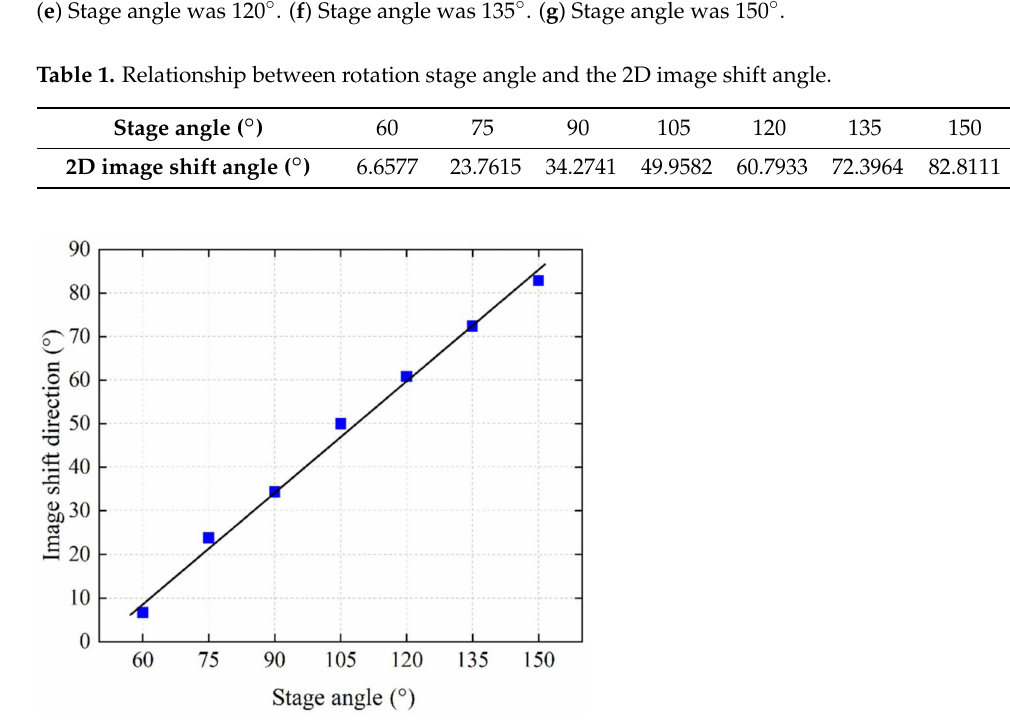
Figure 14. Dependence of the 2D speckle image shift angle and the rotation stage